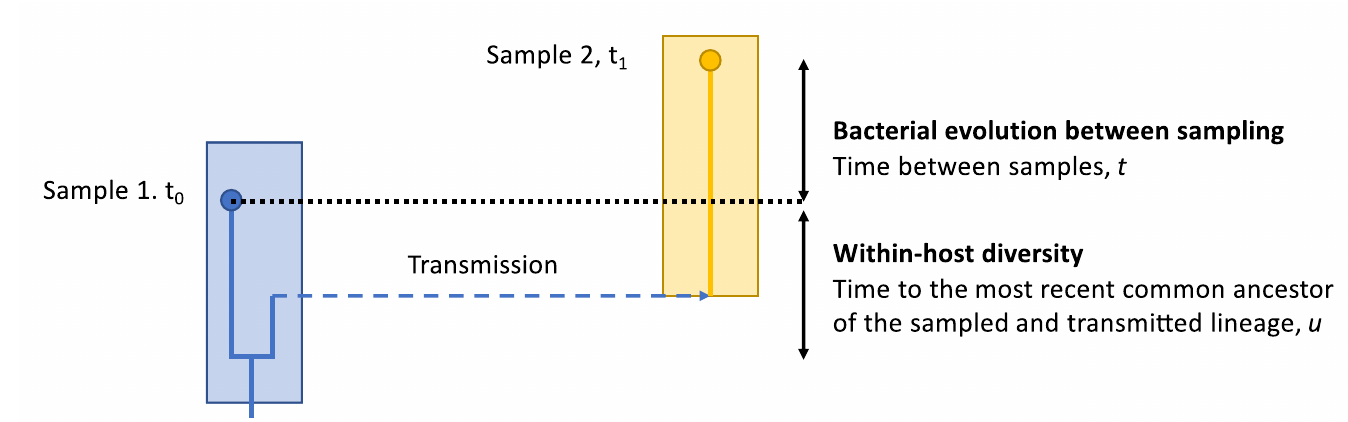
Fig 2. Coalescent-based model. Each box represents an infected patient (blue: patient j , yellow: patient i ). Time runs from the bottom of the plot to the top. Samples are shown as circles. t 0 denotes the time of the first sample, t 1 the time of the second sample. t is the time between the samples, and u the time between the first sample and the common ancestor of the samples.